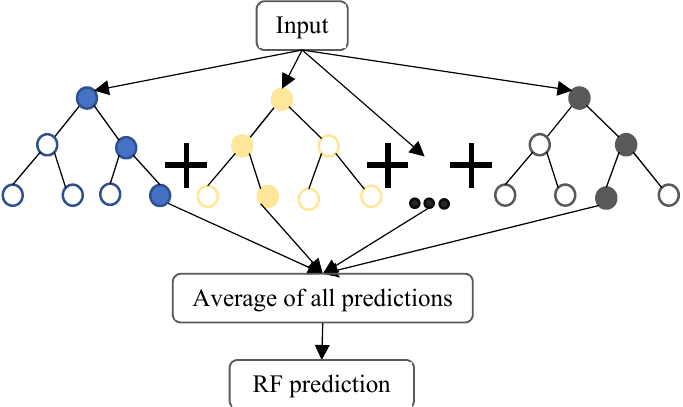
Figure A1. The architecture of Random Forest.